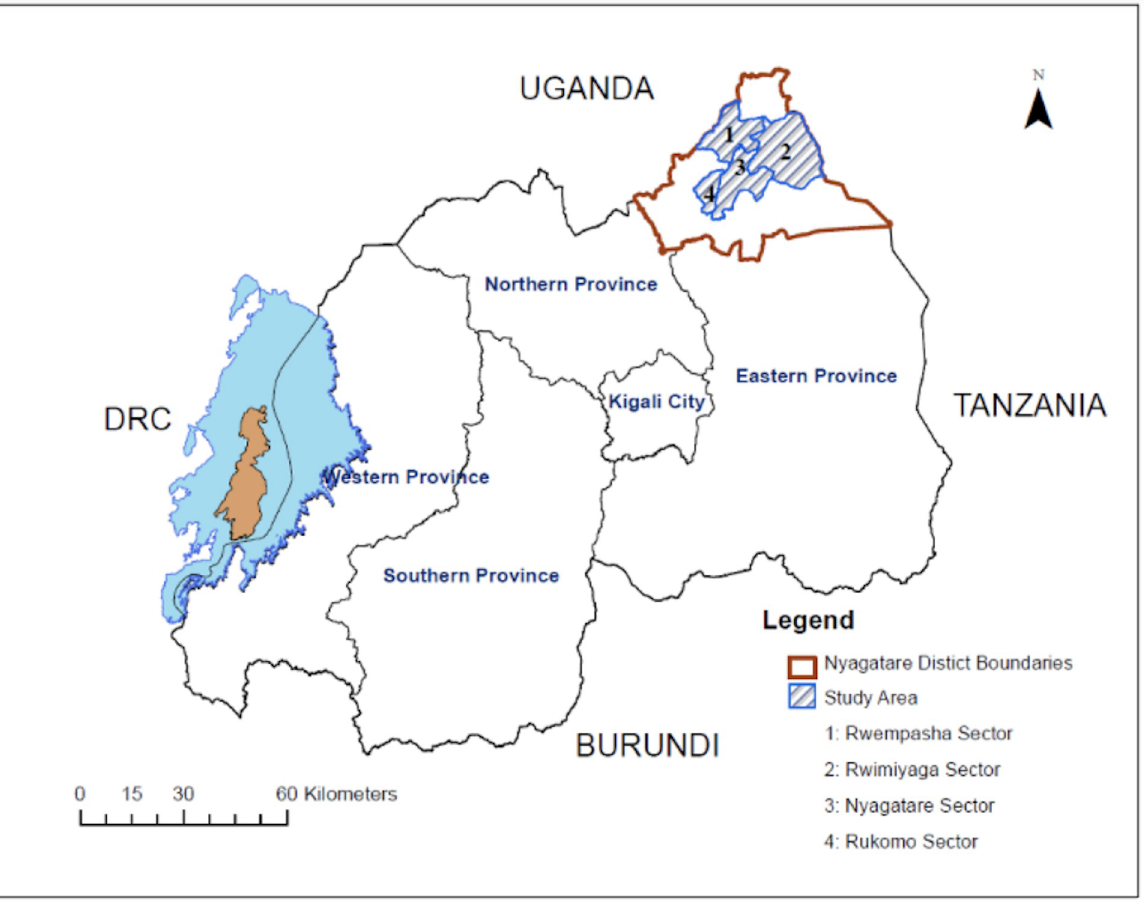
Fig 1. Map of study area. This map was created using QGIS Ver. 10.5. The layers are freely accessible from https://www.diva-gis.org/datadown and they can be shared under CC-BY license